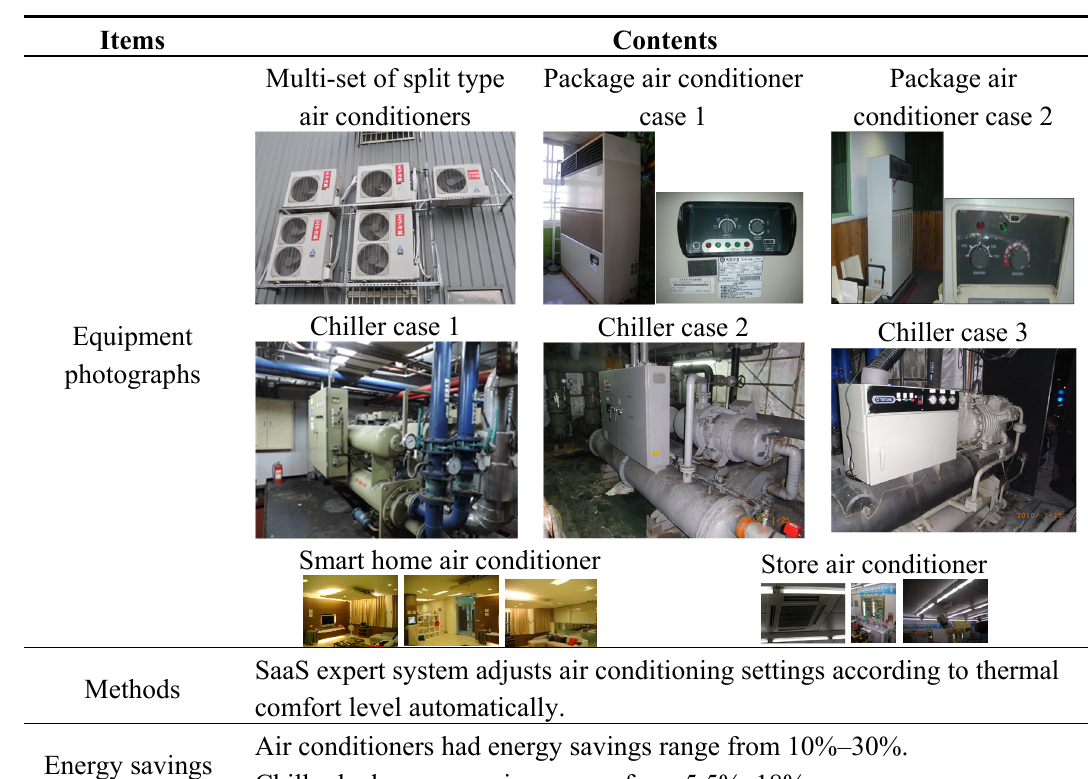
Table 7. HVCA systems managed by cloud